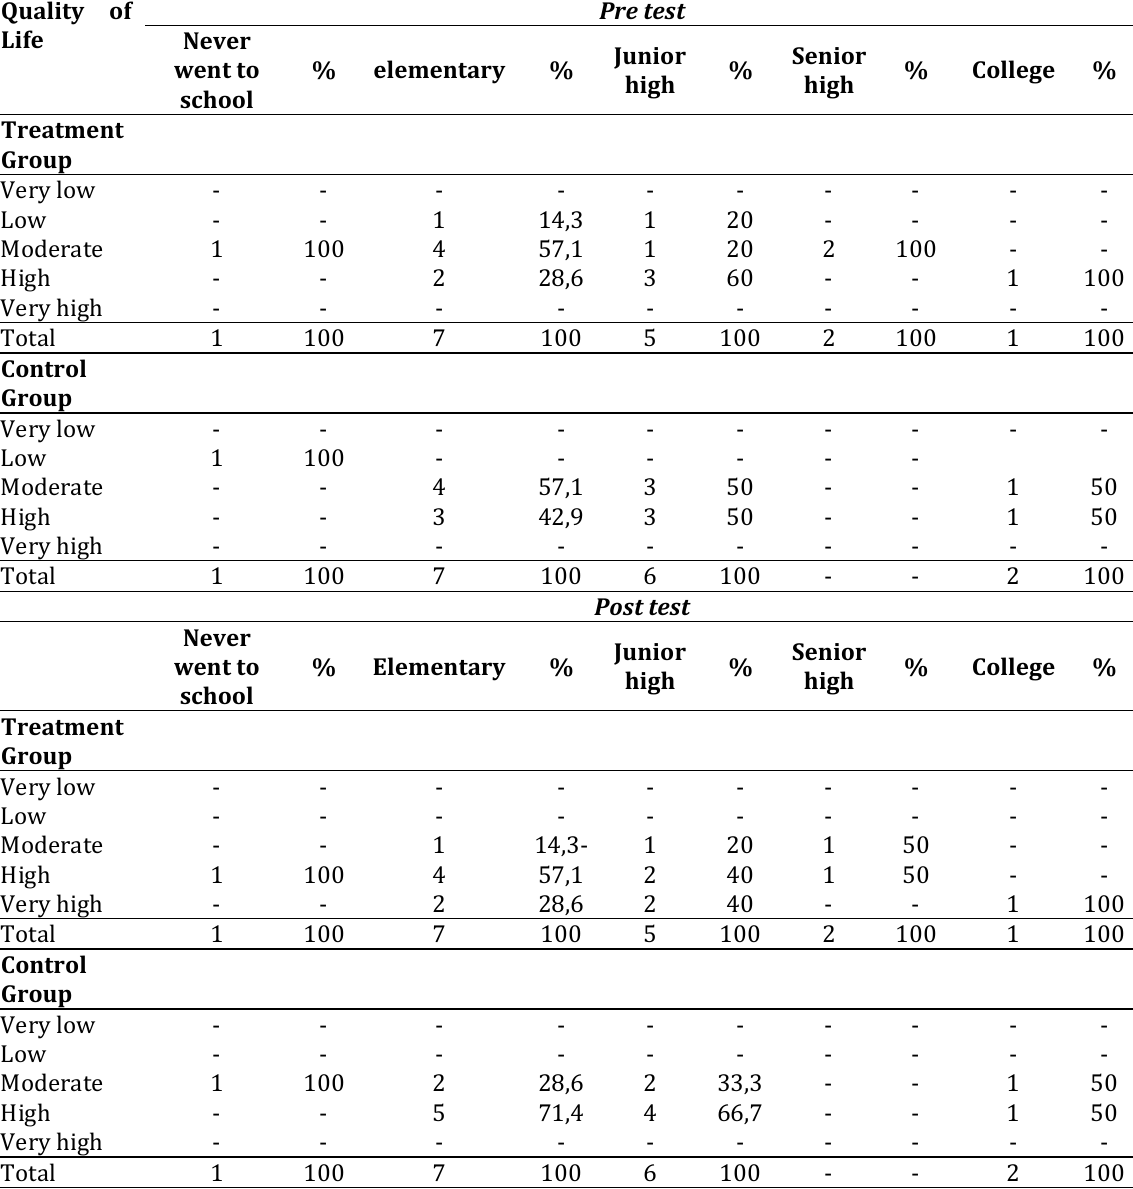
Table 6 Quality of Life by Type of Education Quality